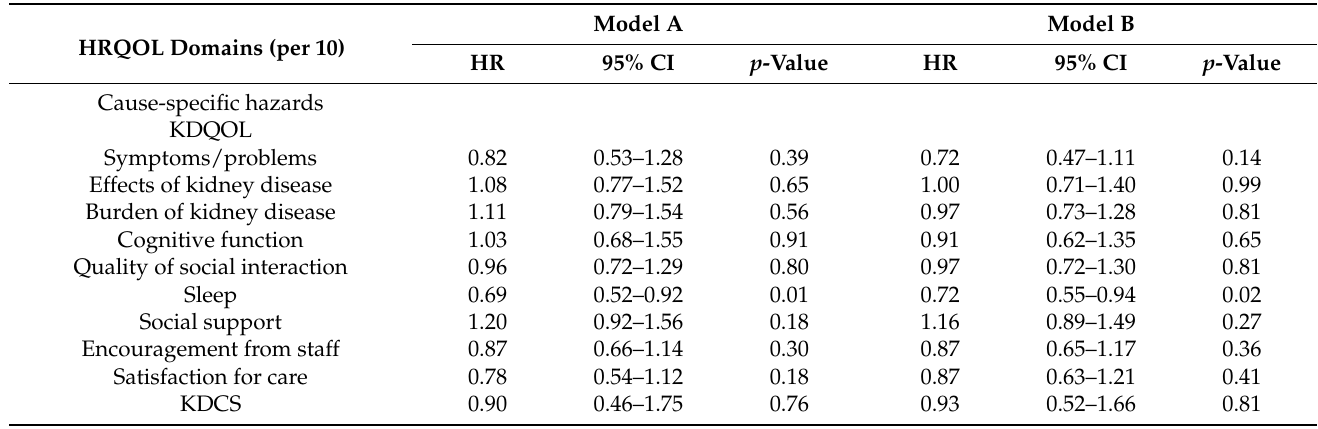
Table 3. Association of health-related quality of life (KDQOL/SF-36) components with hemodialysis transfer using adjusted standard Cox regression models and Fine and Gray subdistribution hazard models (models A and